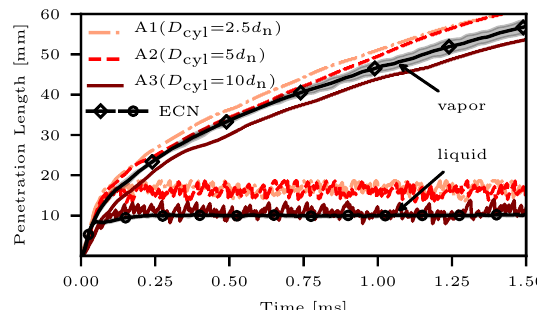
Figure 4. Time-resolved liquid and vapor penetration for varied D cyl and constant V cyl = 25 π d 3 n , compared with ECN data. Filled region denotes ECN experimental uncertainty within an